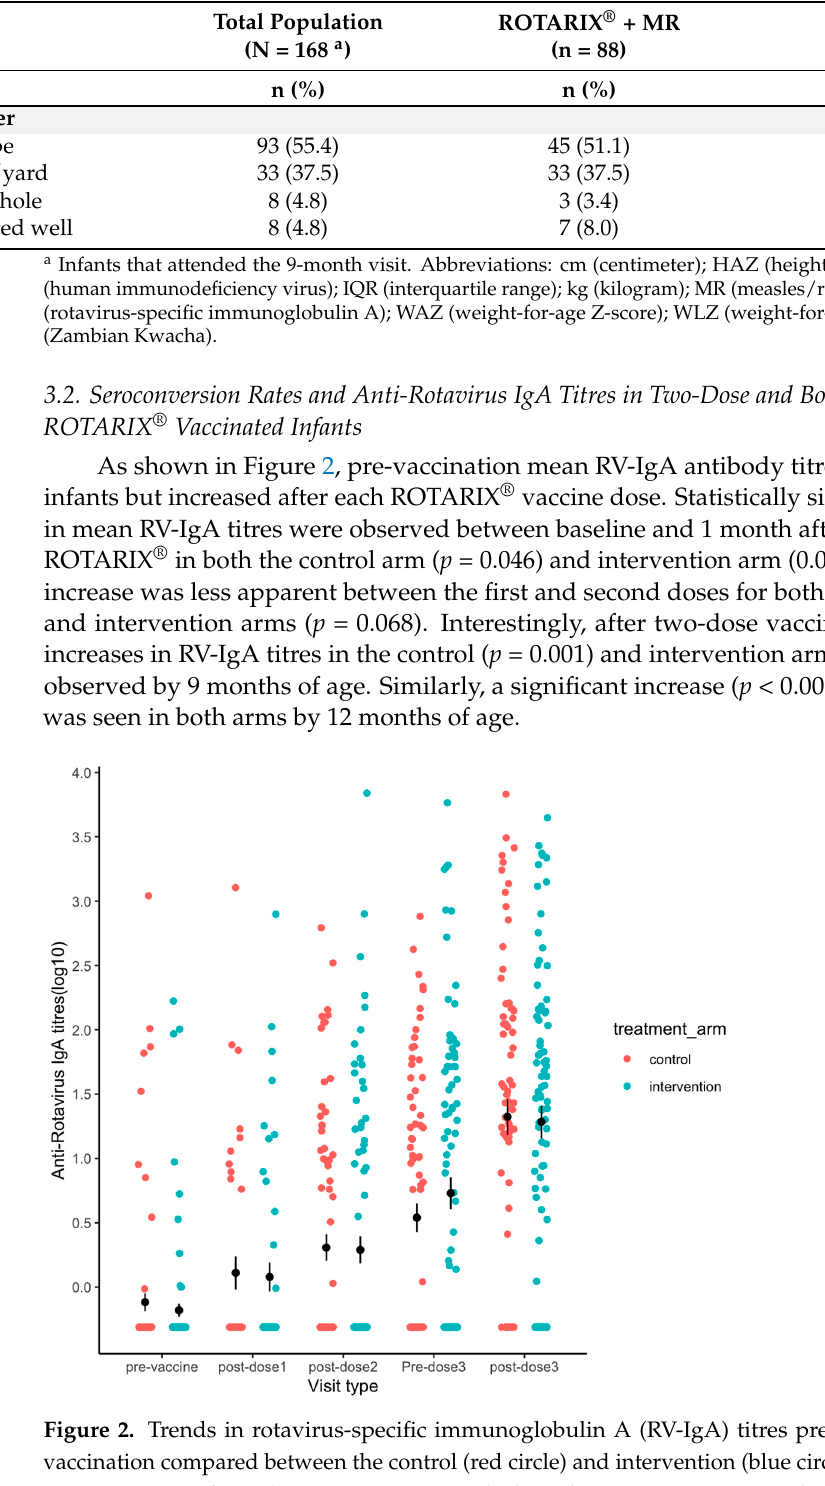
Table 2. Rotavirus IgA geometric titre mean ratio at 12 months by study arm.